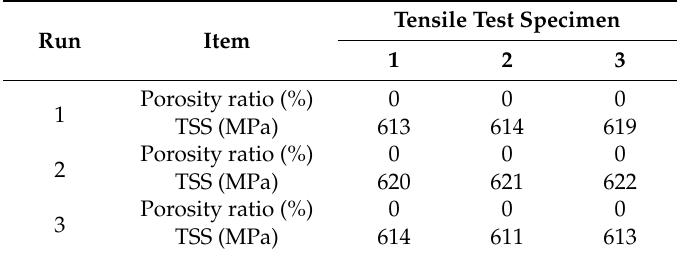
Table 7. Porosity and TSS of each test specimen (gap: 0.5 mm).